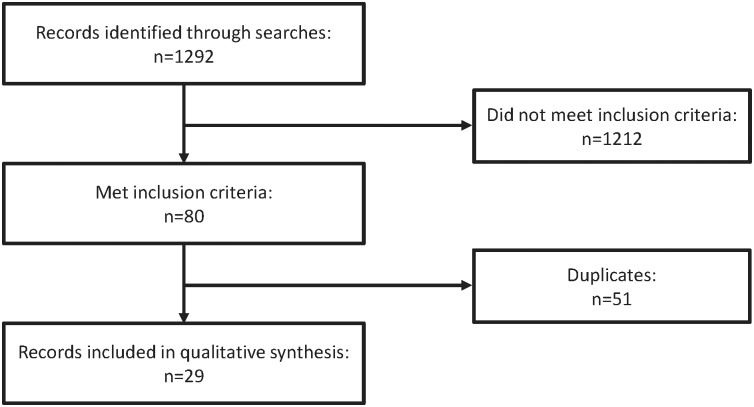
Flow diagram of literature search for systematic review.